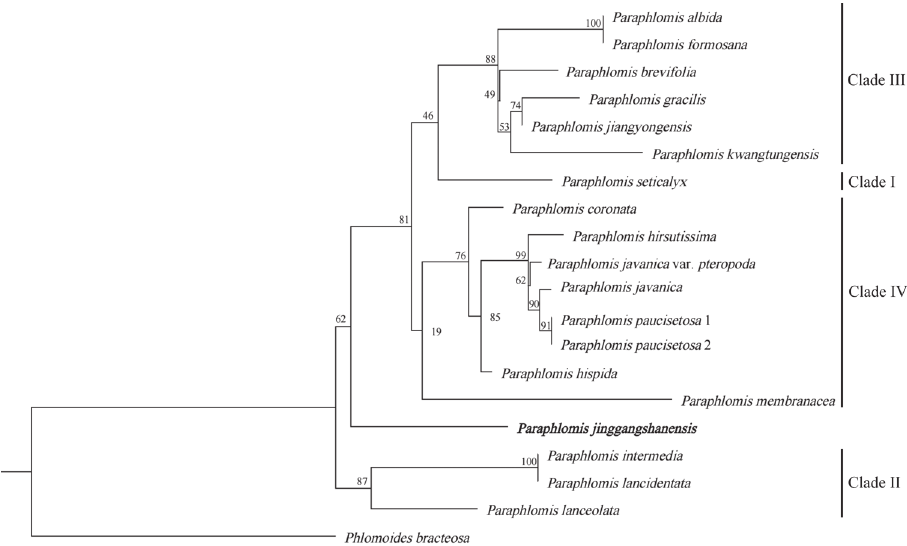
Figure 1. Phylogenetic relationships among 17 species of Paraphlomis and Phlomoides bracteosa based on ITS sequences. Numbers above branches indicate Maximum Likelihood bootstraps (ML). The new spe- cies described in this study is shown in